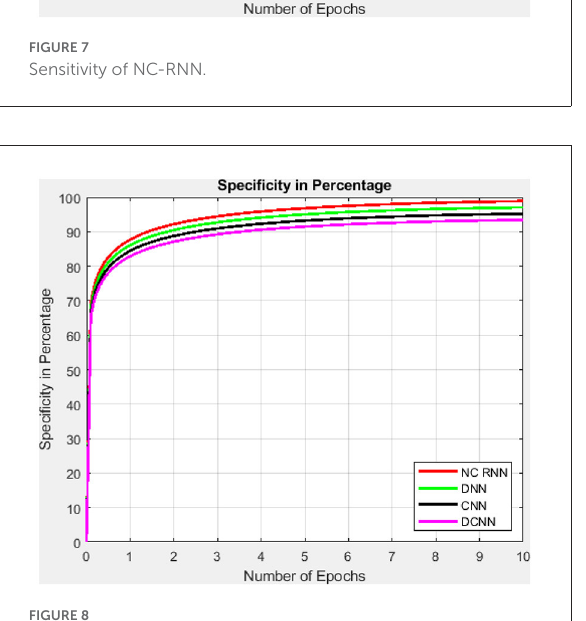
FIGURE8 Specificity of